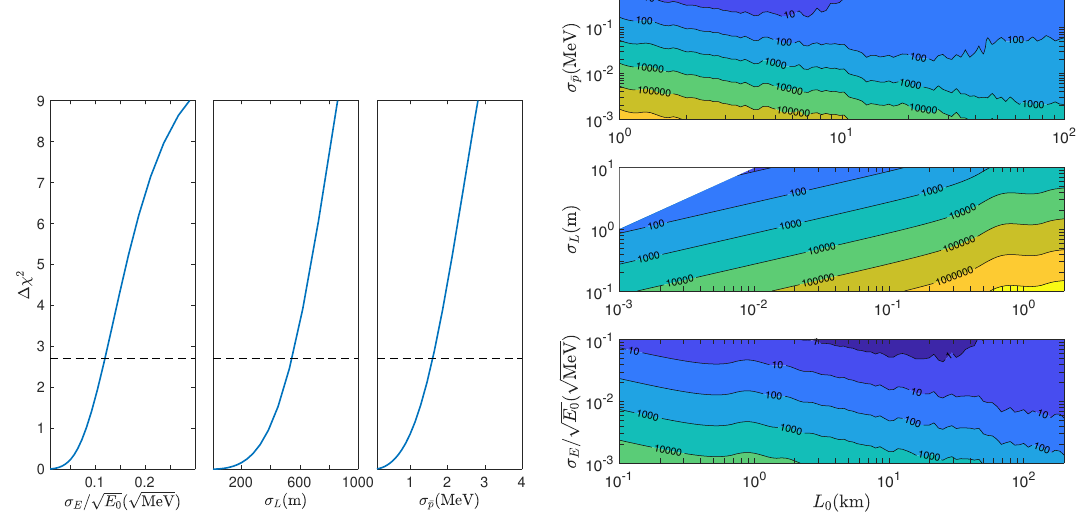
Figure 14 . Taking RENO as a benchmark experiment for reactor neutrinos, the left three plots present the constraints on different decoherence parameters from a fit to RENO data. The right plot takes the obtained 90% CL limit on σ from the left plots. It shows the contour lines for n evaluating how-many-times statistics compared to the current RENO data are needed to achieve a 90% CL sensitivity for some decoherence parameter and baseline, which is λ in eq. (4.7). The while area in the middle figure is cut out since it would indicate that the detector is inside the reactor